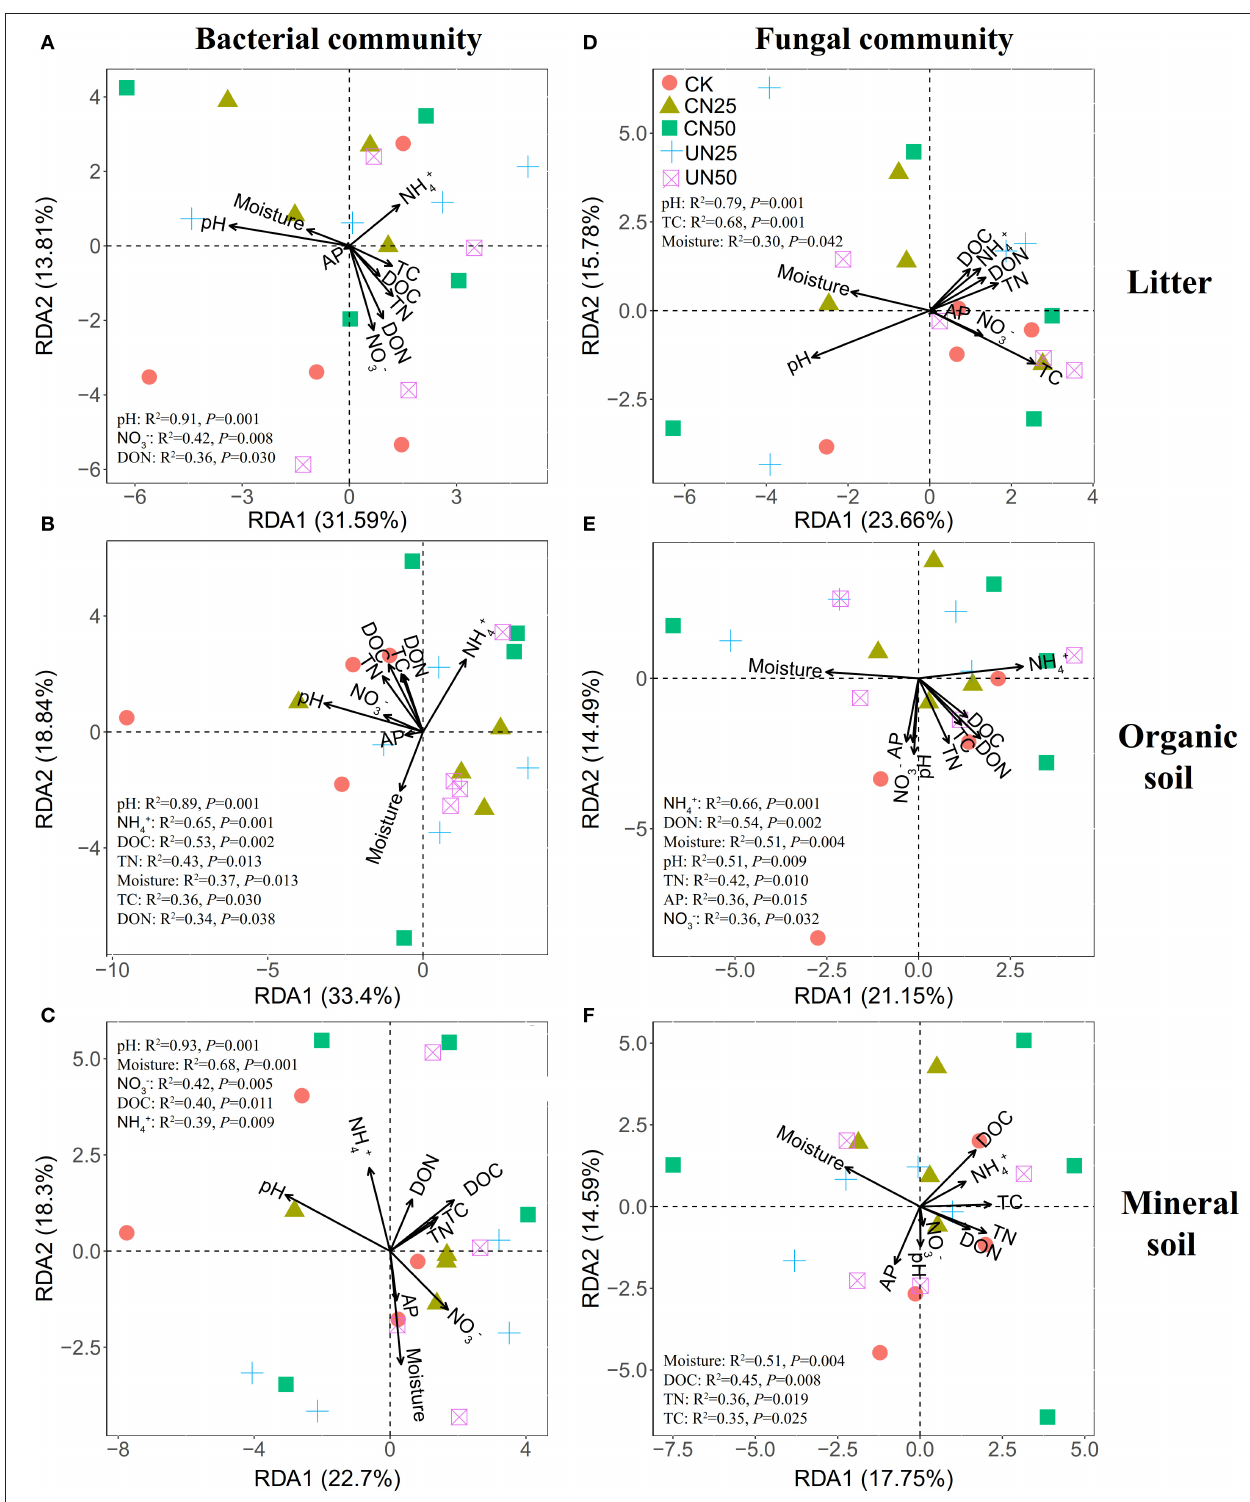
FIGURE 4 | Redundancy analysis (RDA) of bacterial (A–C) and fungal (D–F) community compositions under different N addition treatments in different soil layers. Significant influencing factors derived from Monte Carlo tests are shown ( P < 0.05).